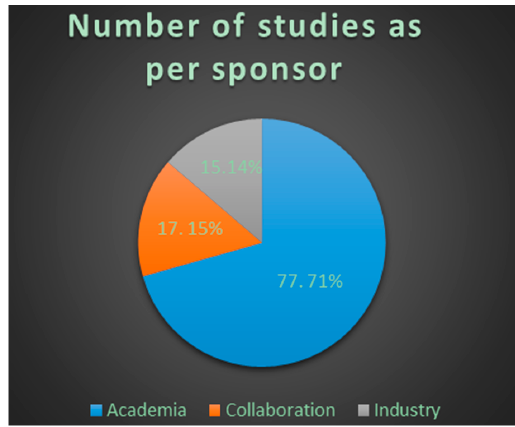
Figure 2. Number and percentage of trials per sponsor using proteomic approaches in clinical studies. Data from clinicaltrials.gov 2002–2016. Collaboration represents clinical studies conducted by academic institutes in collaboration with industry.